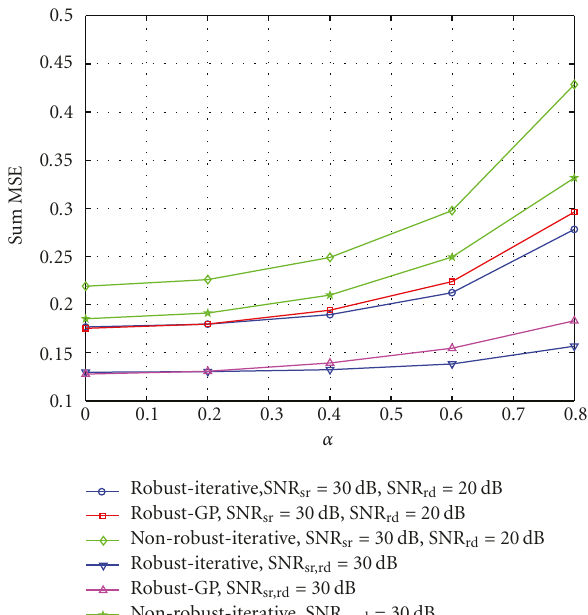
Figure 5: Sum MSE as a function of α for the relay channel without the direct link ( β = 0, σ 2